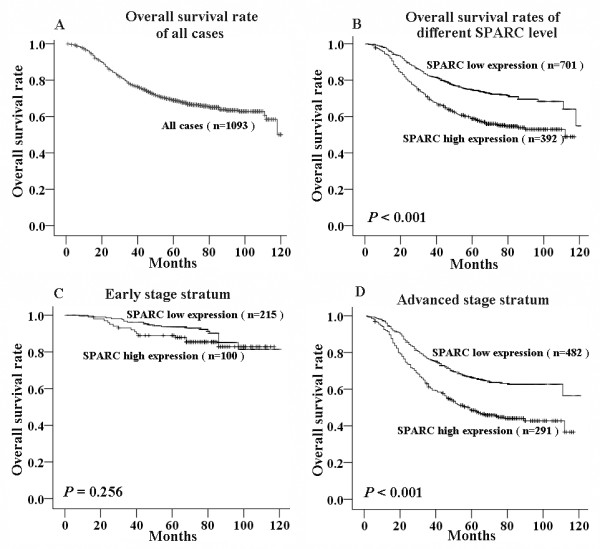
Kaplan-Meier survival curve and log-rank test for NPC patients classified as showing either high or low SPARC expression. (A) Kaplan-Meier curve for 5-year overall survival rate (69.1%) of 1093 patients with NPC; (B) Overall survival curve of NPC patients with different SPARC expression and the 5-year OS rate was significantly different between NPC patients with low expression (74.9%) and high expression (58.9%) (P < 0.001; log-rank test); (C) Cases stratified by clinical stage. Within the early stage (Stage I + II) stratum, SPARC expression did not show a statistical (P = 0.256; log-rank test) relationship with patients survival; (D) Within the advanced stage (Stage III + IV) stratum, SPARC expression exhibited a significant (P < 0.001; log-rank test) relationship with patients survival.